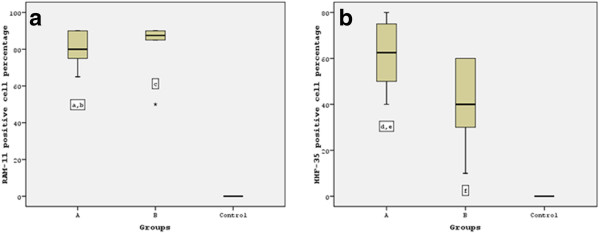
RAM-11 and HHF-35 positive cell distribution in three groups. a. No significant difference in RAM-11 cell percentage was observed between angioplasty induced and spontaneous atherosclerotic lesions: a P = non significant, Bonferroni’s post hoc ANOVA analysis vs Group B; b P < 0.001, Bonferroni’s post hoc ANOVA analysis vs contol; c P < 0.001, Bonferroni’s post hoc ANOVA analysis vs control. b. Significant increase in HHF-35 cells was noticed in angioplasty induced atherosclerotic lesions: d P < 0.05, Tamhane’s post hoc ANOVA analysis vs Group B; e P < 0.001, Tamhane’s post hoc ANOVA analysis vs control; f P < 0.001, Tamhane’s post hoc ANOVA analysis vs control.